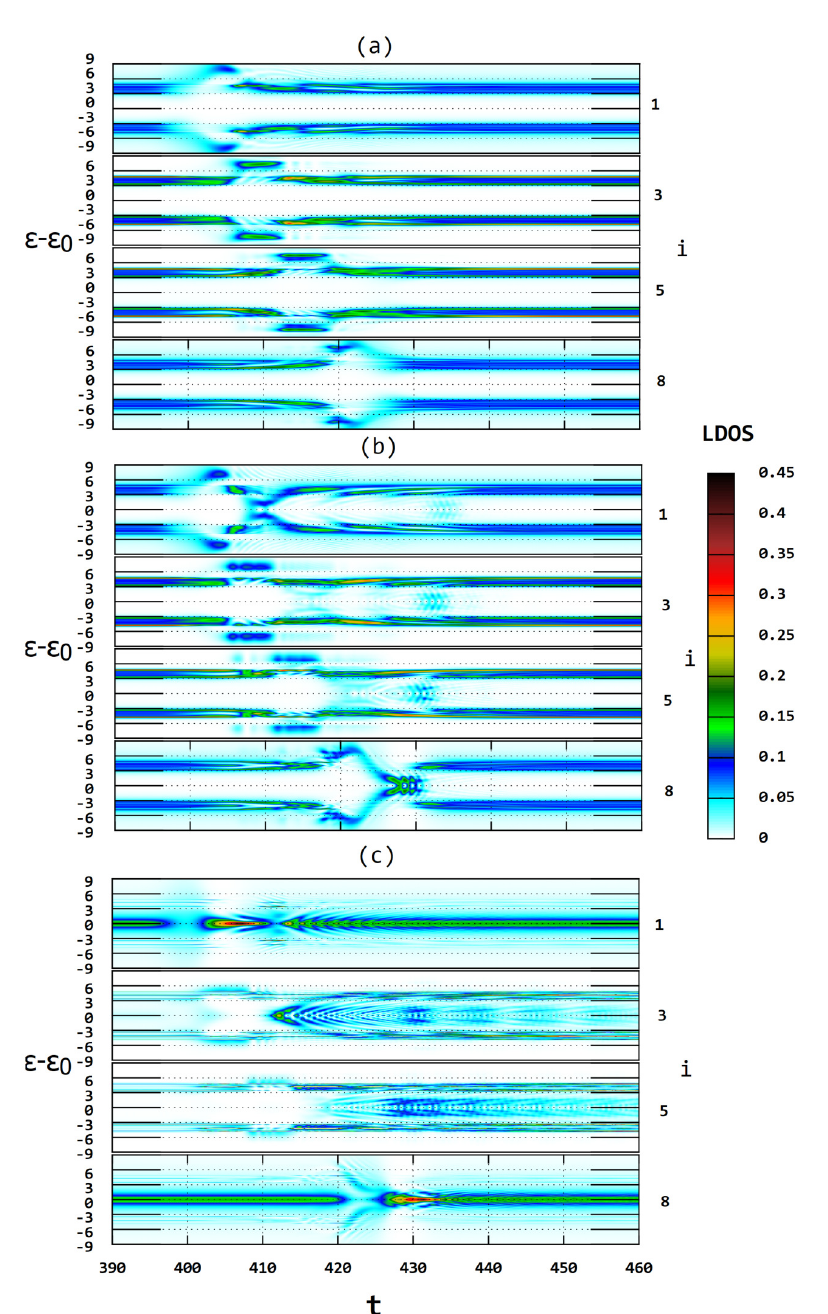
Figure 4. LDOS time evolution at i = 1,3,5 and 8 sites of the SSH trivial chain [ V = 4, W = 1, panels ( a , b )] and nontrivial chain [ V = 1, W = 4, panel ( c )] composed of N = 8 sites. Panel ( a ) represents the system disturbed by the one-Gaussian perturbation, panels ( b , c ) correspond to the two-Gaussian impulse, the same as in Figure